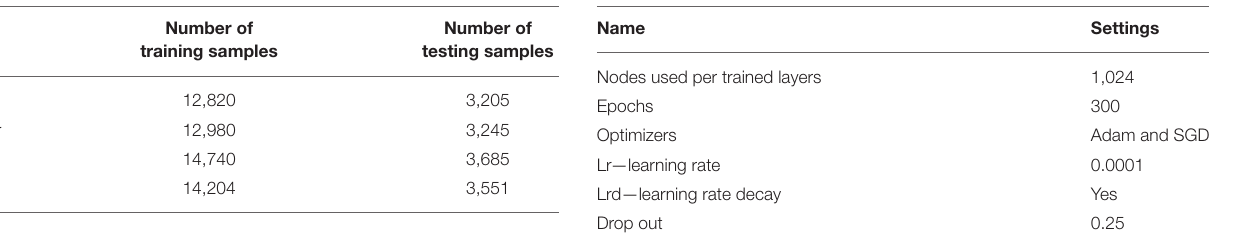
TABLE 4 | Hyperparameters